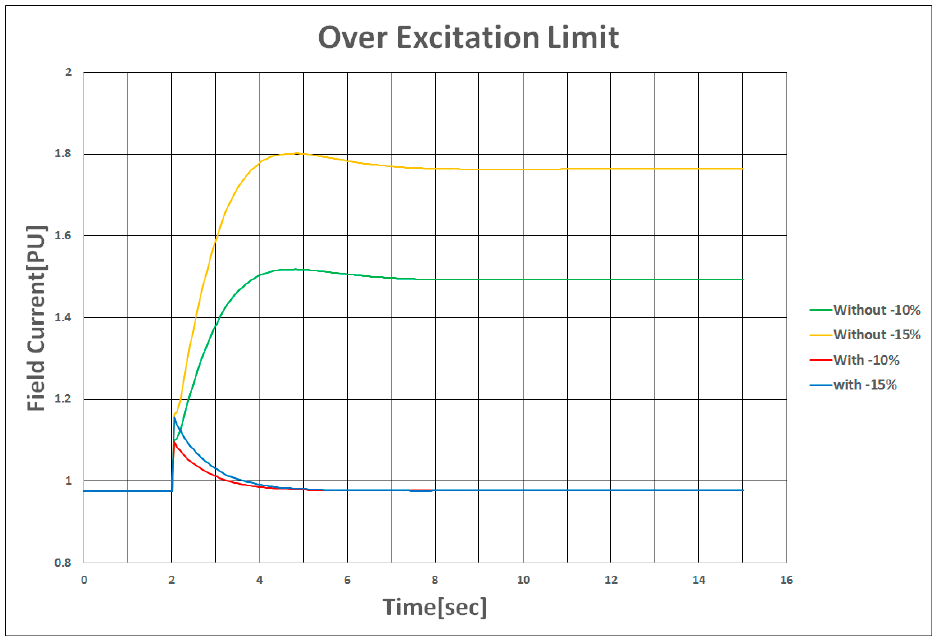
Figure 11. Comparison of results.